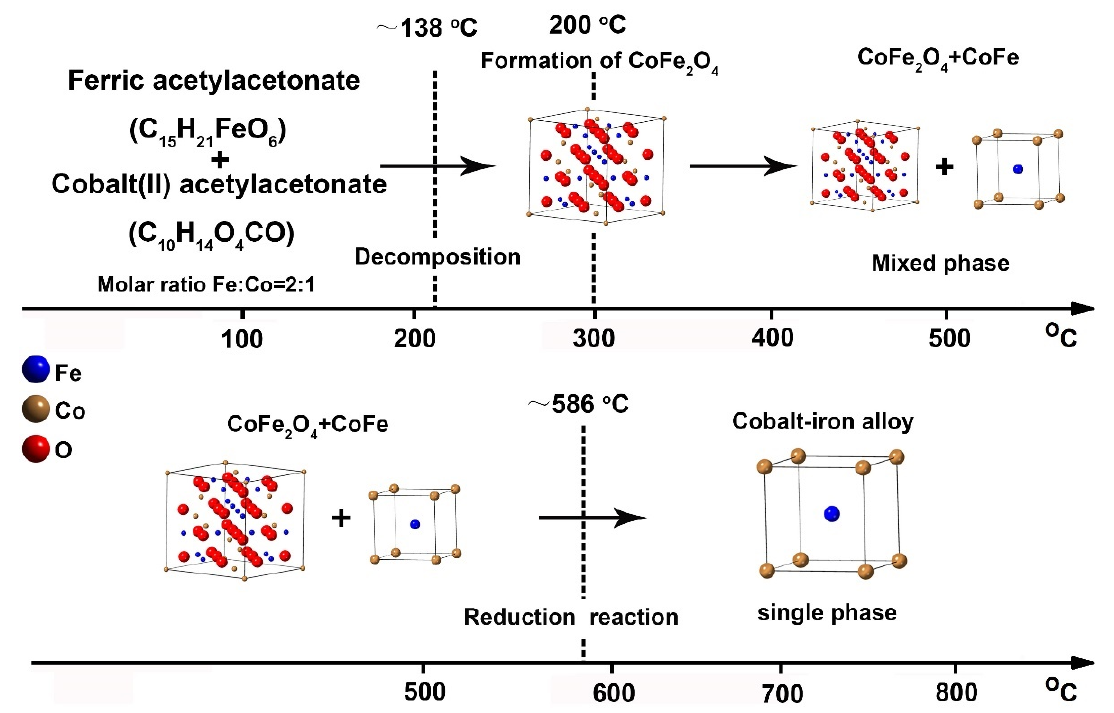
Figure 8. Phase transition of cobalt-Fe-based nanocrystals in carbon submicron fibers with heteroge- neous structures.